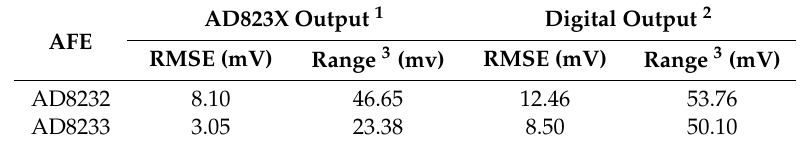
Table 10. Baseline noise of breadboard prototype. RMSE and range variation over ECG baseline reference.